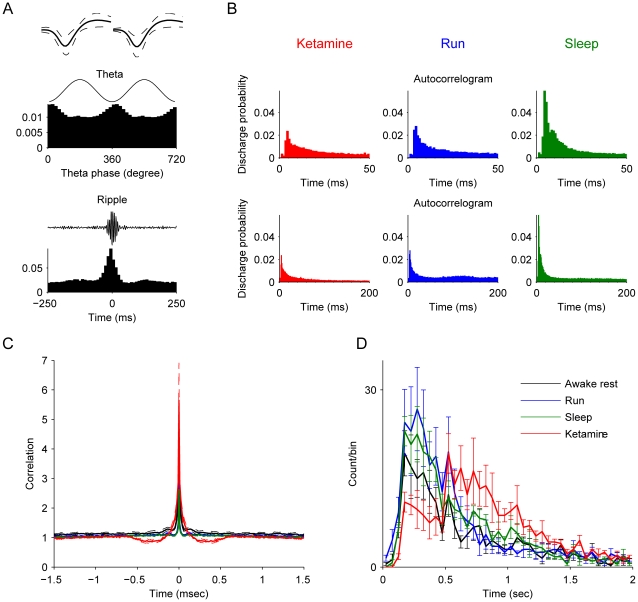
Pyramidal cell properties in the absence or presence of ketamine.(A) Averaged spike waveforms of 211 recorded pyramidal cells by using stereotrode are shown in left upper panel, solid lines represent the mean spike waveforms and the dashed lines indicate the mean±S.D. The middle and lower left panels illustrate the spike timing of pyramidal cells with relationship to theta oscillations and ripple epochs respectively. (B) The average auto-correlations of pyramidal cells 5 min after ketamine injection, and during sleep and running are shown. Autocorrelograms are plotted in two different time scales. (C) Auto-correlation function of joint-activities of pyramidal cells. (D) Averaged interval histograms of pyramidal cell synchronous epochs over animals. Note the peak about 0.6 sec of the red line indicates that pyramidal cells exhibited slow rhythmical firings.